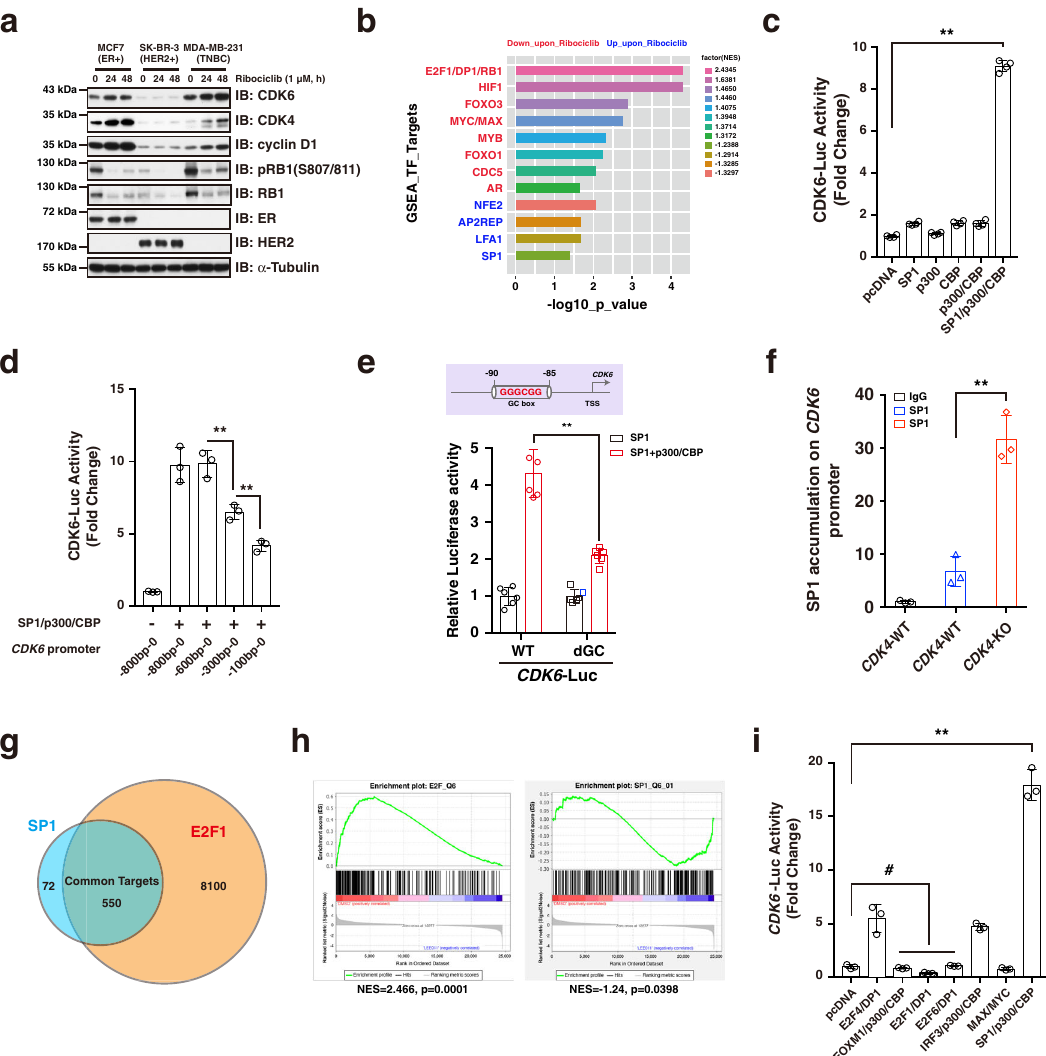
Fig. 4 Inhibition of CDK4/6 facilitates SP1-mediated CDK6 upregulation. a Ribociclib treatment led to CDK6 accumulation in a time-dependent manner in MCF7 and MDA-MB-231 cells. b GSEA analysis showing the enriched and suppressed transcription factors upon ribociclib treatment in MDA-MB-231 cells. The P values were calculated using Kolmogorov-Smirnov tests. c Luciferase reporter assay showing that SP1/p300/CBP complex governs CDK6- promoter driven luciferase expression ( n = 4). The P value was calculated by Student ’ s t-test (two-sided). ** P < 0.01. d Luciferase reporter assay showing that the promoter region of -600bp~0 bp of CDK6 is responsible for SP1/p300/CBP-mediated induction of luciferase expression ( n = 3). The P values were calculated by Student ’ s t-test (two-sided). ** P < 0.01. e Luciferase reporter assay showing that the conserved GC box in CDK6 promoter region is necessary for SP1/p300/CBP regulation of luciferase expression ( n = 6). The P values were calculated by Student ’ s t-test (two-sided). ** P < 0.01. f ChIP analysis showing that SP1 accumulation on the CDK6 promoter region is signi fi cantly enriched in the context of CDK4 depletion in MDA-MB-231 cells ( n = 3). The P values were calculated by Student ’ s t-test (two-sided). ** P < 0.01. g ChIP-seq analysis showing the overlap of target genes regulated by SP1 and E2F1. h GSAE analysis showing that the E2F target was reduced, while SP1_Q6_01 genes were increased in the context of ribociclib treatment in MDA-MB-231 cells. The P values were calculated using Kolmogorov – Smirnov tests. i Luciferase reporter assay showing that the SP1/p300/CBP complex plays a major role in regulating CDK6 transcription ( n = 3). The P values were calculated by Student ’ s t-test (two-sided). #: no signi fi cant difference, ** P < 0.01. Data are presented as mean values ± SEM. The relevant raw data and uncropped blots are provided in Source